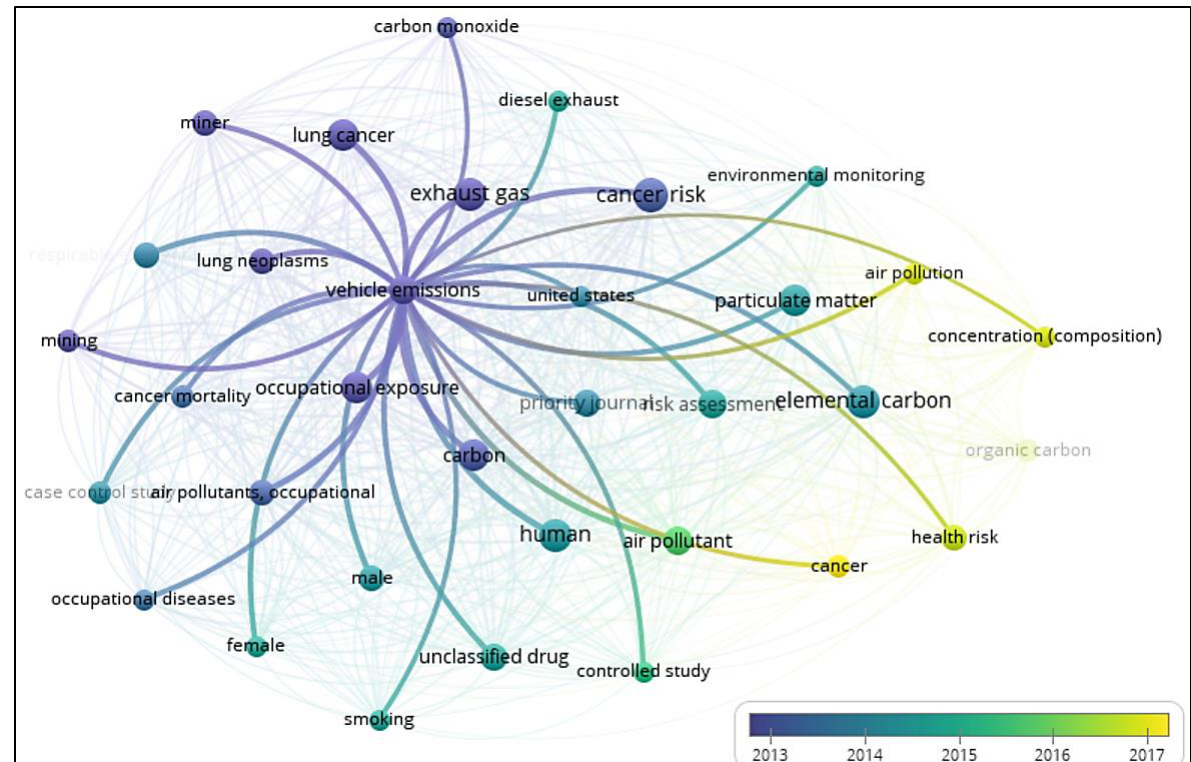
Figure 1. Keyword analysis of recent studies evaluated through Vosviewer.